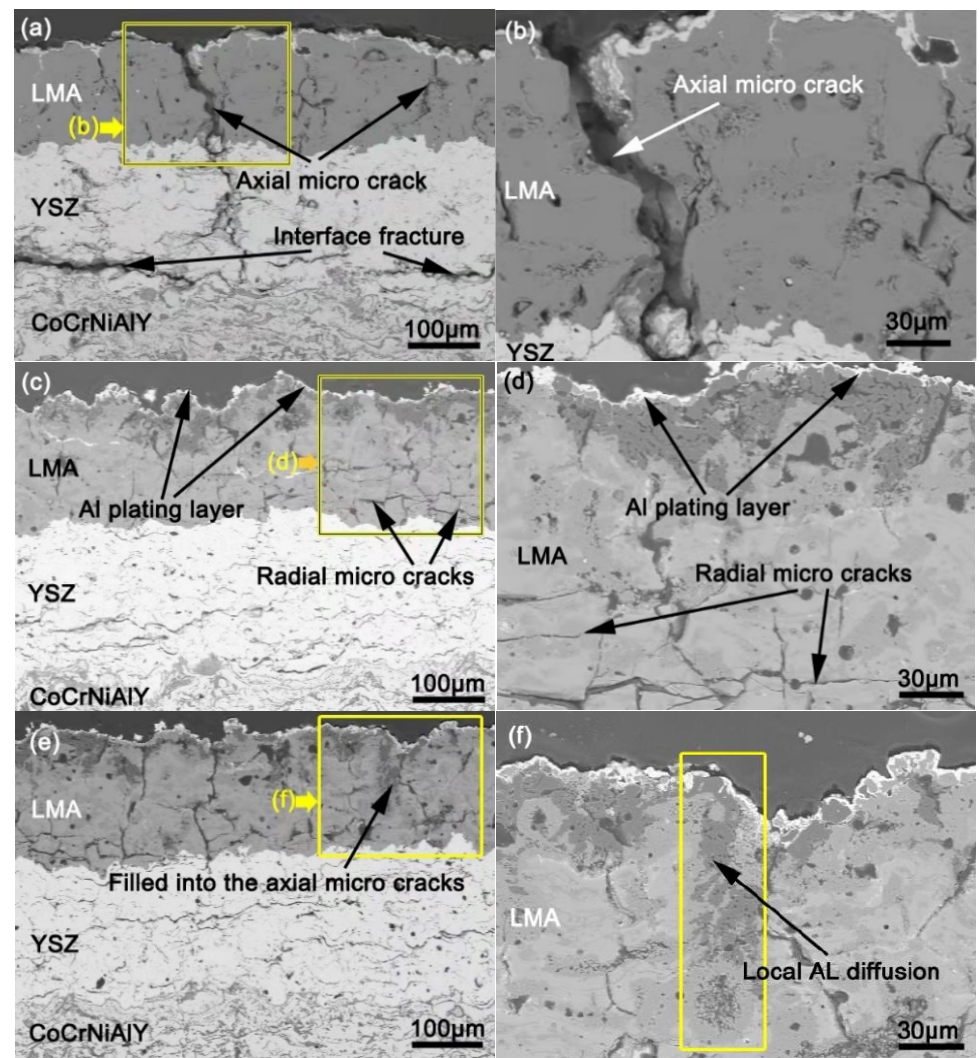
Figure 12. SEM cross-sectional images of all coatings after oxidation test at 1200 °C working temperature: ( a , b ) M1; ( c , d ) M2S1; ( e , f ) M2S2.